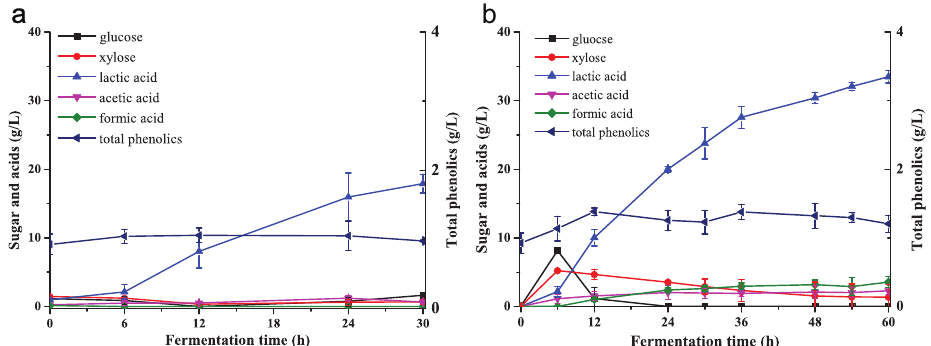
Figure 5. Lactic acid fermentation of biodetoxified and non-detoxified corn stover in batch SSF. K. huakuii LAM0618 T -biodetoxified or non-detoxified corn stover were used as the substrates for lactic acid fermentation by B. coagulans LA204 in a 5 L bioreactor. Fermentation curves for glucose, xylose, lactic acid, acetic acid, and formic acid with ( a ) 8% ( w / w ) of NH 3 /H 2 O 2 -pretreated but unwashed corn stover, or ( b ) 8% ( w / w ) of NH 3 /H 2 O 2 -pretreated and biodetoxified corn stover. All experiments were performed in duplicate and results are presented as mean ± SD. Error bars indicate SD. Lactic